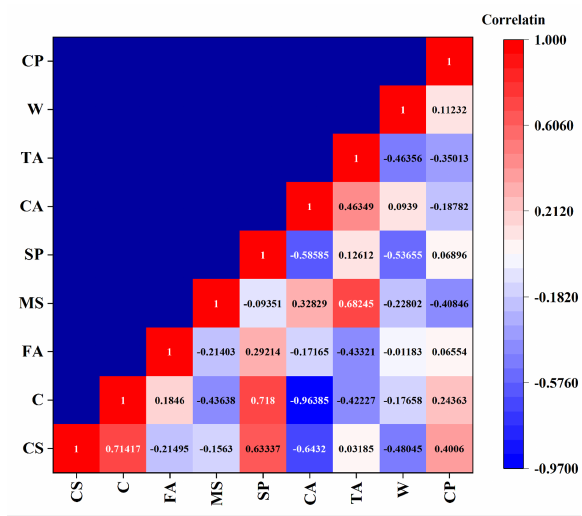
Fig. 3. The correlation between the input variables and target value shown as a heat